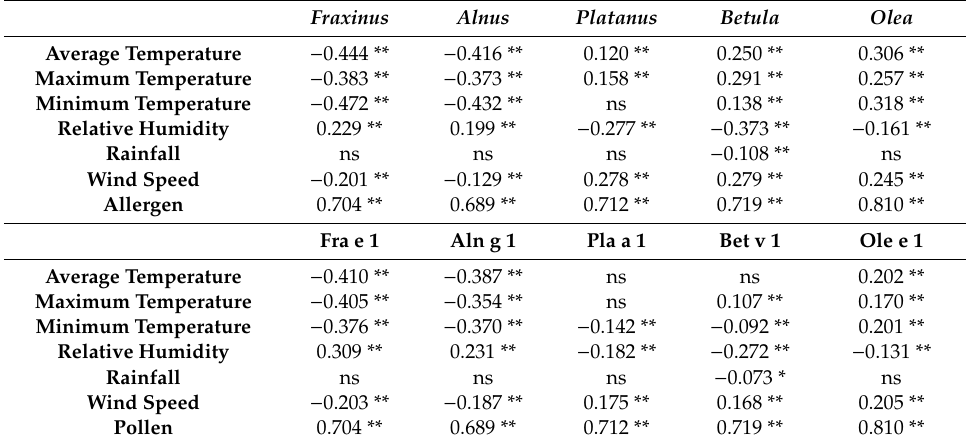
Table 2. Spearman correlations between pollen or allergen and the main meteorological variables (* p < 0.05; ** p < 0.01). Fraxinus